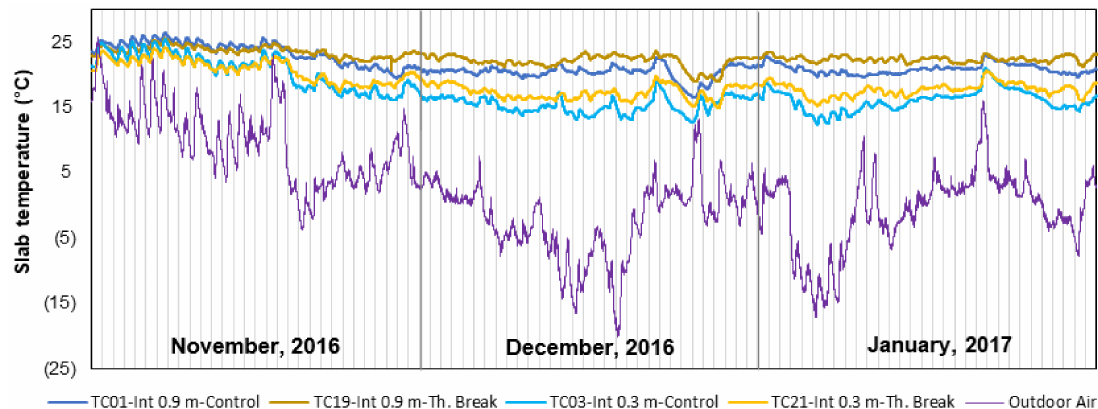
Figure 9. Interior floor slab temperature of the control and thermally-broken balconies (pair